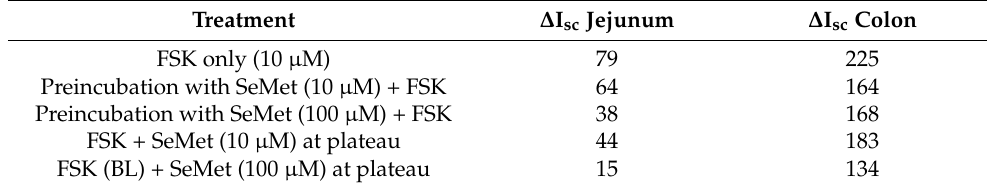
Table 1. Effect of SeMet on FSK-stimulated ∆ I sc in rat jejunum and colonic mucosae. Treatment ∆ I sc Jejunum ∆ I sc Colon FSK only (10 µ M) 79 225